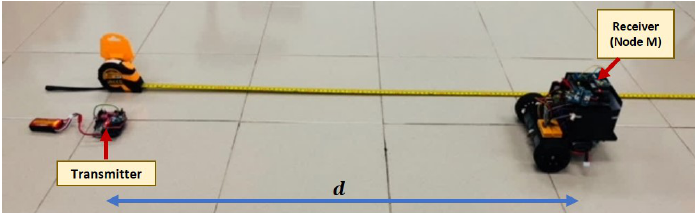
Figure 1. NSBot2: A nonholonomic wheeled mobile robot equipped with ATMega microcontrollers and Zigbee radio modules with IEEE 802.15.4 standard.